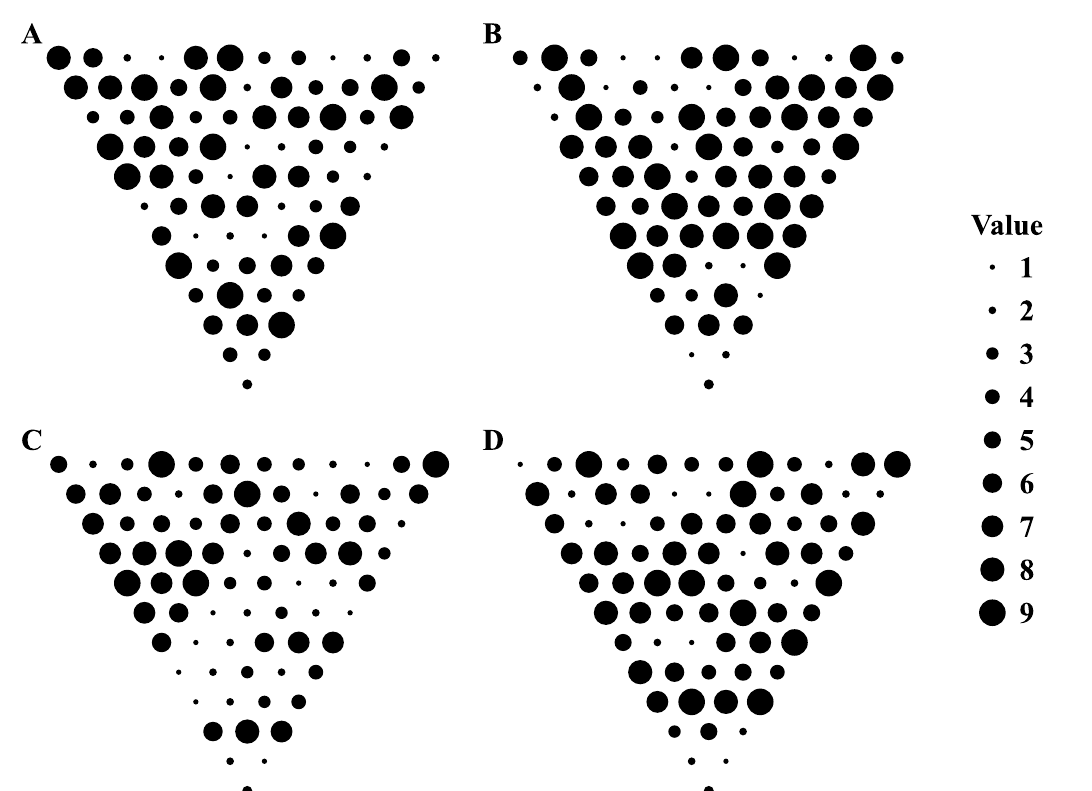
Fig 4. (A – D) Four instances of the maximally-informative stimuli. The stimuli were designed to maximize our ability to infer planning strategies from the observed behavior. Disk size represents its